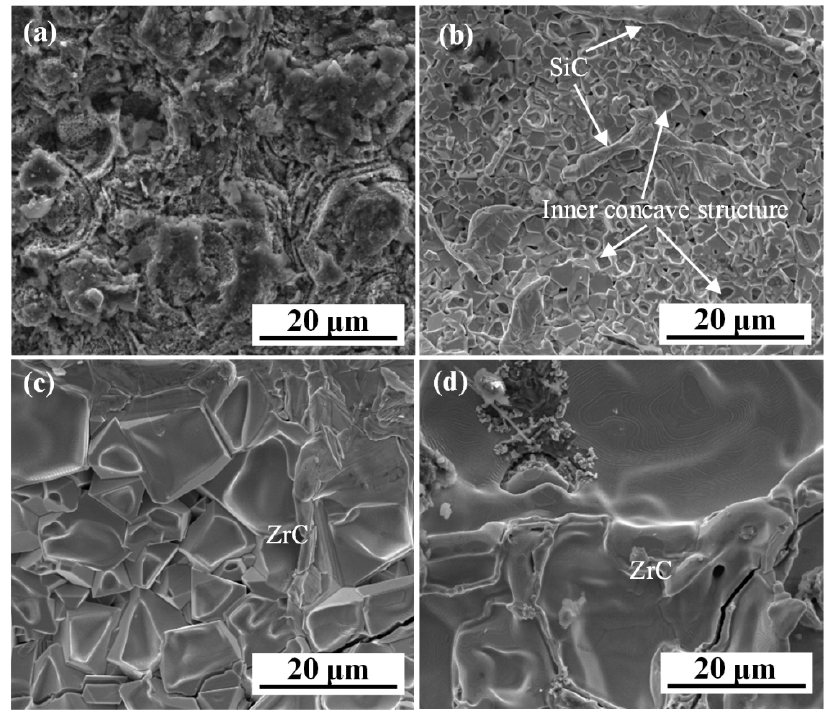
Figure 2. Surface images of prepared inner layer: ( a ) 1450 °C; ( b ) 1550 °C; ( c ) 1650 °C; ( d ) 1750 °C.